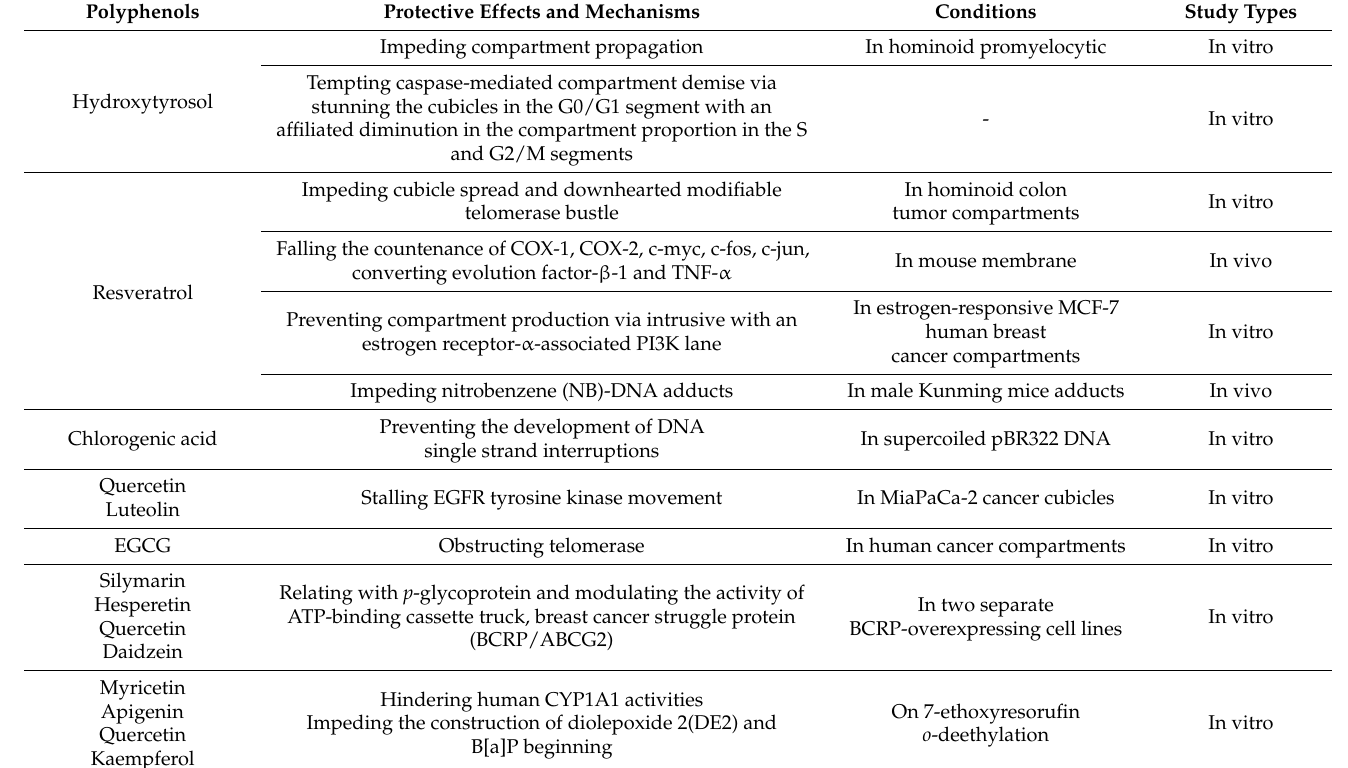
Table 5. Phenolic compound pharmacological profile against cancer cell lines